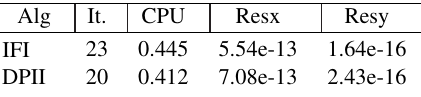
Table 2. Numerical results for Example 2